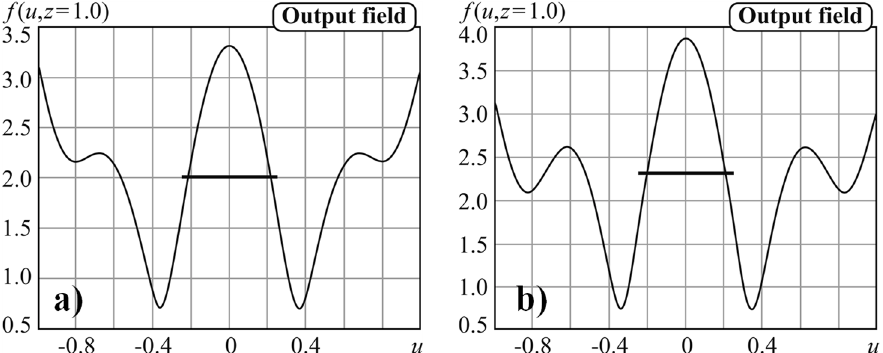
Figure 8. The amplitude of the field of Equation (6) with a = 10 and N = 20 propagated at the distance z = λ for different sizes of the input field: ( a ) Т = 2.5, ( b ) Т = 10. z = λ for different sizes of the input field: ( a ) T = 2.5, ( b ) T = 10.